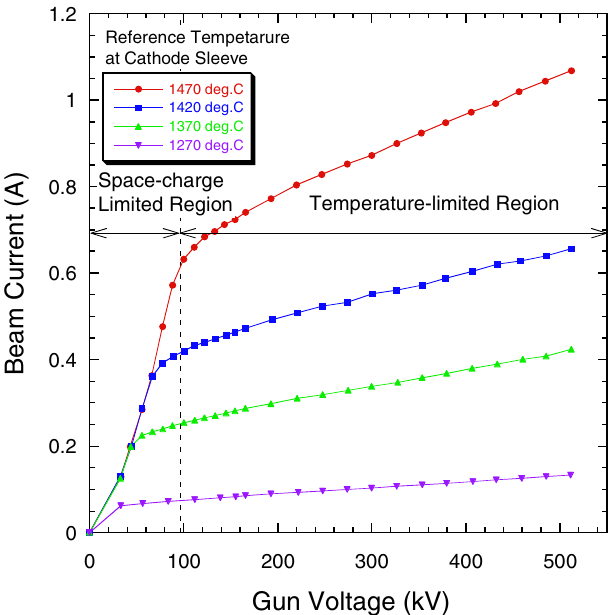
FIG. 7. (Color) Current-voltage characteristics of the CeB